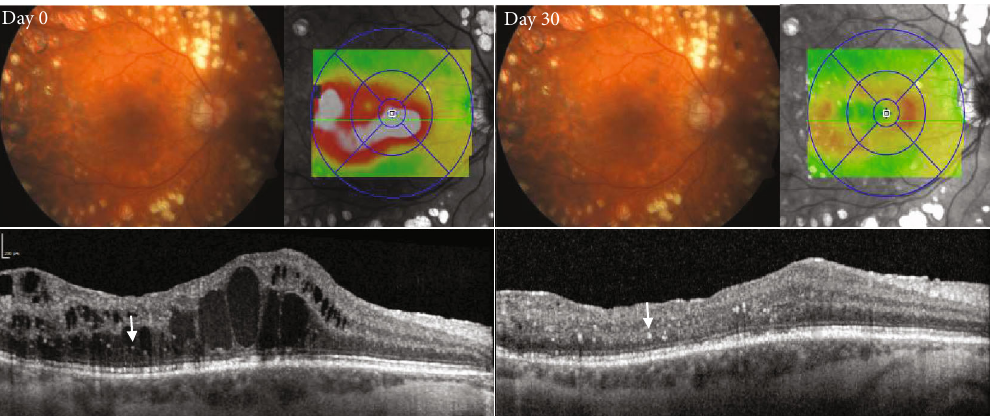
Figure 4: Treatment response of hyperre fl ective foci (HF) after dexamethasone implantation in a patient with diabetic macular edema (DME). Color fundus photograph (CFP), spectral-domain optical coherence tomography (SD-OCT) B-scan, and infrared image with Early Treatment Diabetic Retinopathy Study (EDTRS) grid depicting extent of DME (red and grey color) at baseline (left panel, day 0) and one month after dexamethasone injection (right panel, day 30) in the same patient as in Figure 1. HF are found adjacent to cystoid spaces in the outer retinal layers. After therapy, the DME resolved and the number of HF clearly decreased.